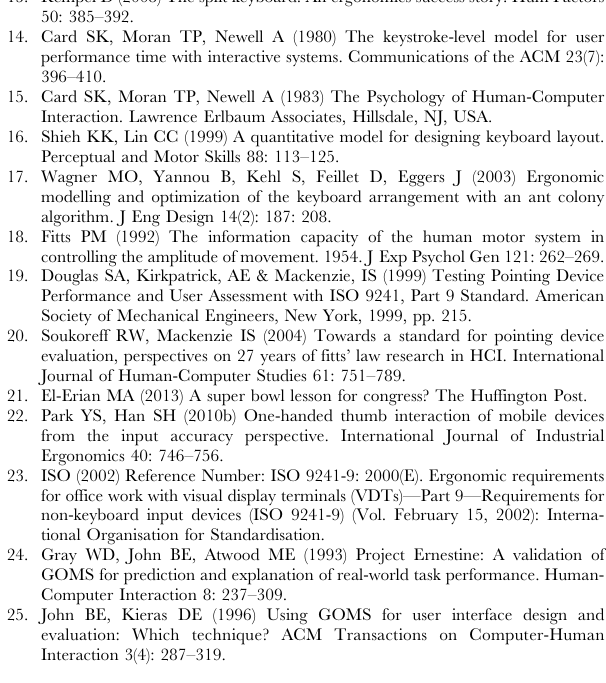
algorithm. J Eng Design 14(2): 187: 208. 18. Fitts PM (1992) The information capacity of the human motor system